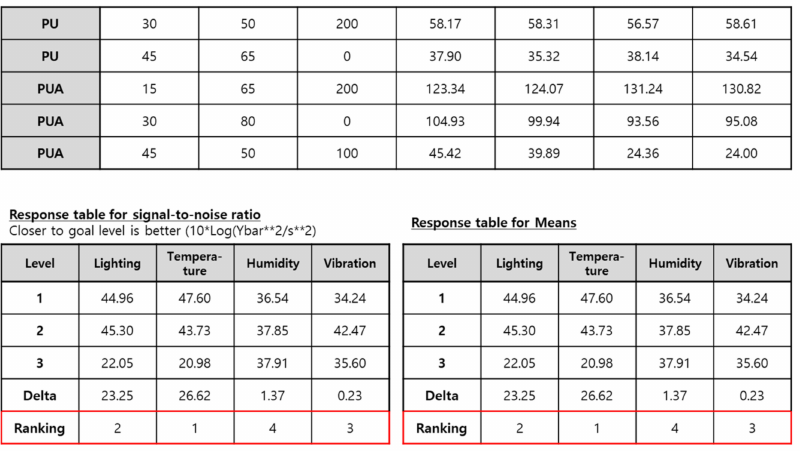
Figure 3. Key factors affecting PV module output obtained using the Taguchi experimental design